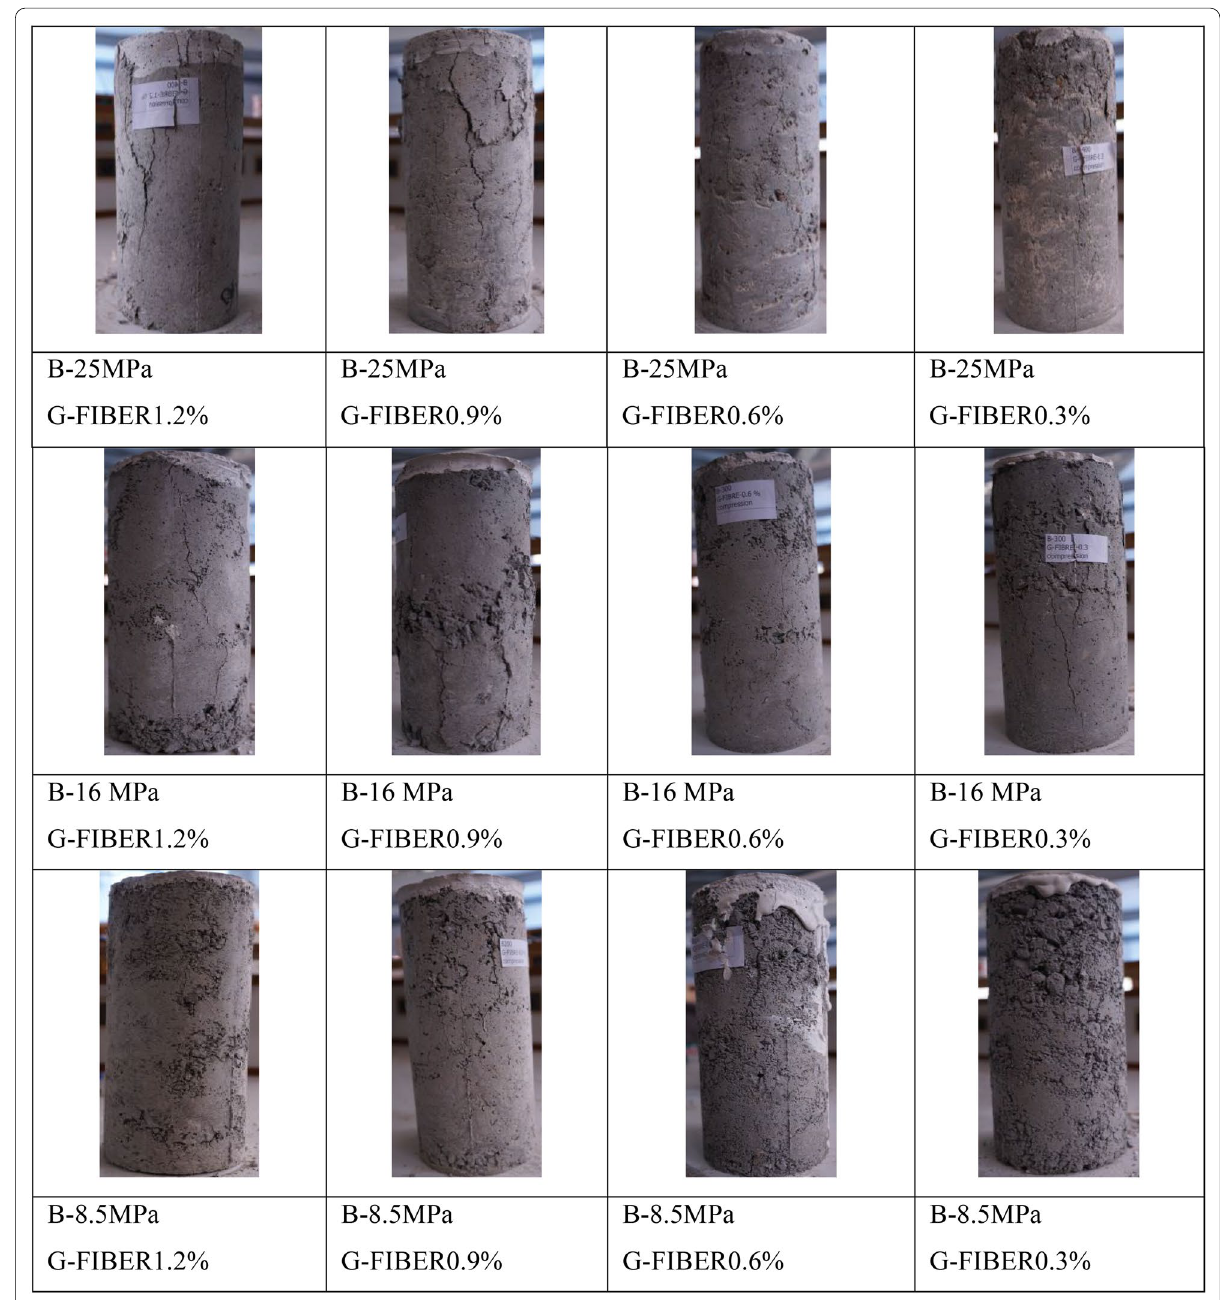
Fig. 5 Crack propagation pattern and failure mode under compression for